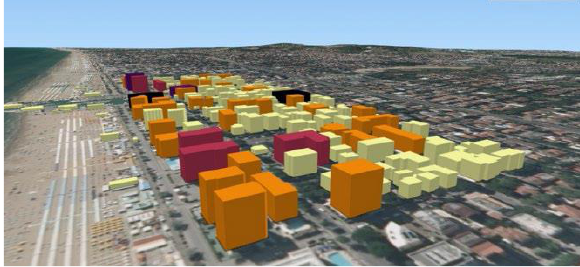
Figure 2. 3D City Model graphical representation with LoD1 buildings classified according to their new volume attribute.